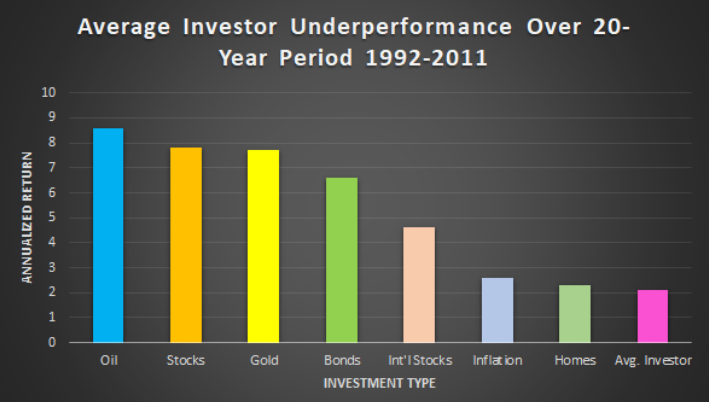
Figure 2. The 20-year performance of various investments (1992–2011) and the poor returns of the average investor. Sources: BlackRock, Bloomberg, Informa Investment Solutions, Dalbar (Ro